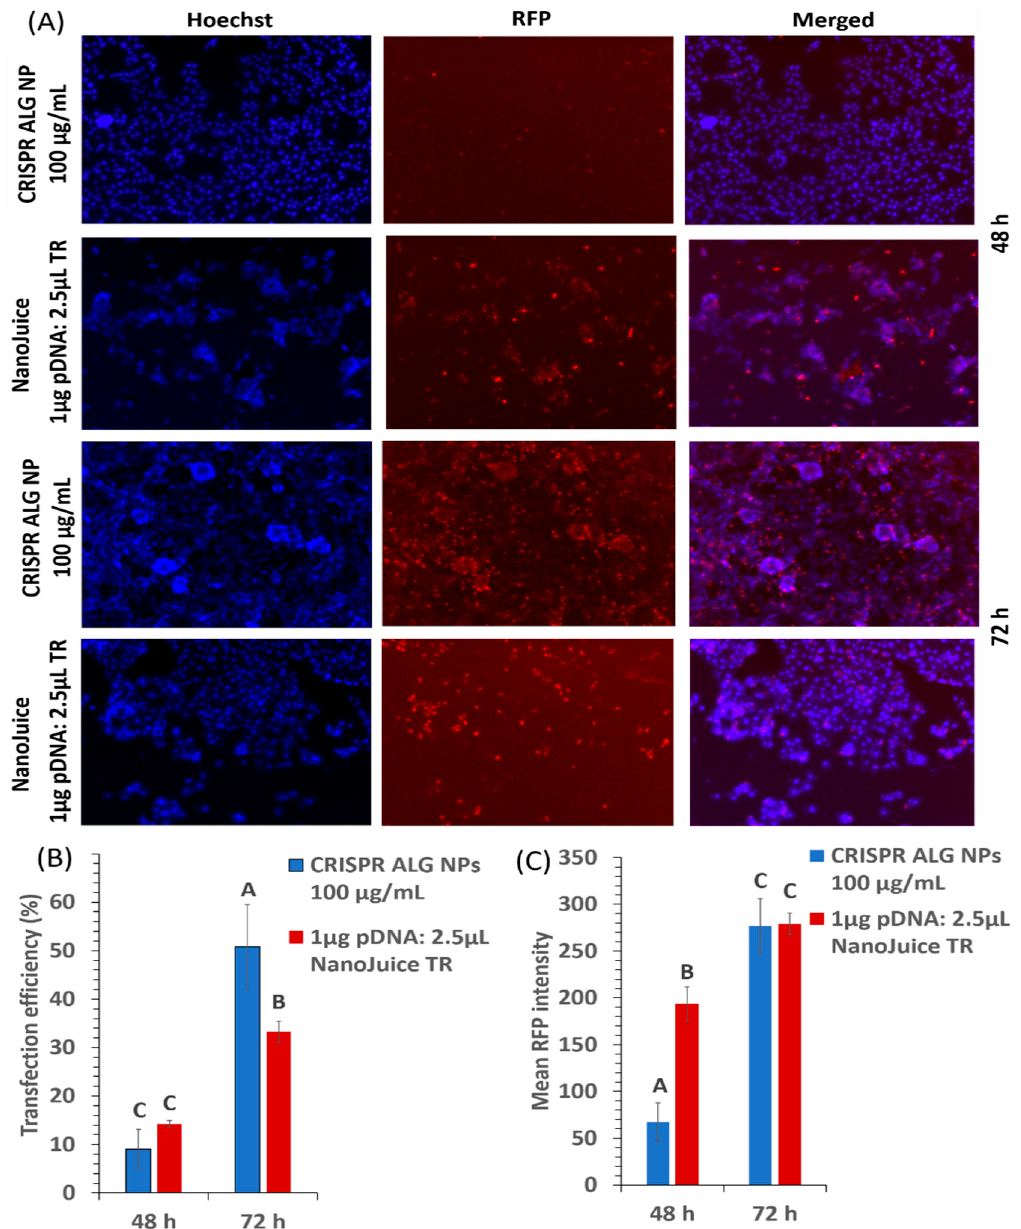
Figure 10. ( A ) Red fluorescence protein (RFP) fluorescence in HepG2 cells 48 h after transfection of RFP-expressing CRISPR plasmid. Panels show blue and red channel for CRISPR ALG NPs, NanoJuice reagent. All photographs were taken at high magnification (field of view 880 × 660 µm). ( B ) Transfection efficiencies by different reagents in HepG2 cells. Bars represent the means ± SD of 3 random cell field photographs at 48 and 72 h. CRISPR ALG NPs was containing CRISPR plasmids in weight ratio 1:10 (pDNA:ALG). The amounts of DNA plasmids used was 1 µg were combined with 2 µL reagent NanoJuice core reagent and 0.5 µL NanoJuice transfection booster. ( C ) Mean red fluorescence intensity expression by different reagents in HepG2 cells 48 h post-transfection. Bars represent the means ± SD of 3 cell fields. CRISPR ALG NPs concentration was 100 µg/mL containing 1 µg CRISPR plasmids. The amounts of DNA plasmids used was 1 µg were combined with 2 µL reagent NanoJuice core reagent and 0.5 µL NanoJuice transfection booster.